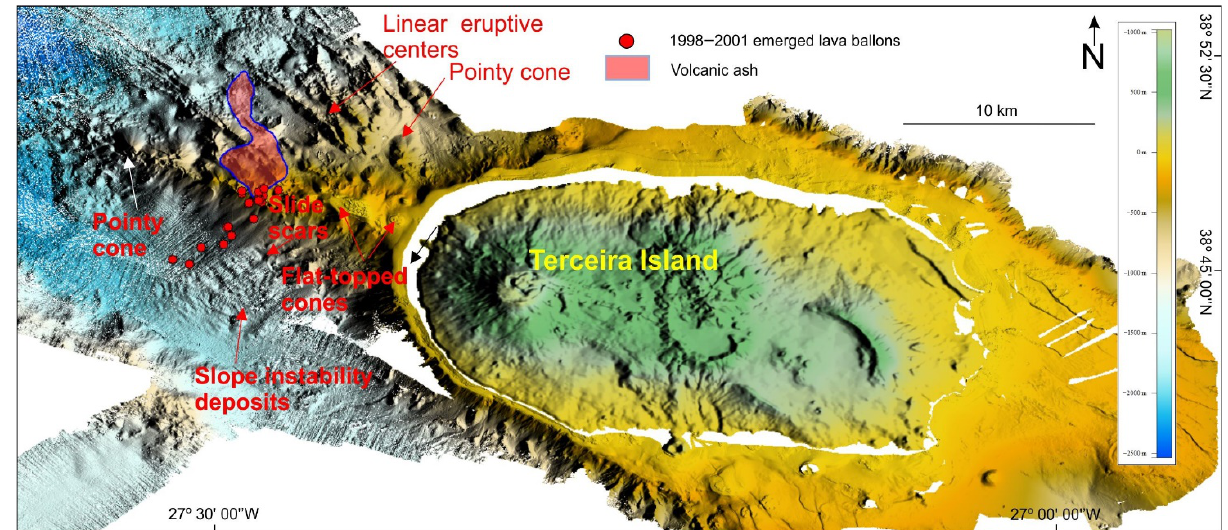
Figure 11. Main characteristics of Terceira Island (Azores; North Atlantic Ocean) and the bathymetry surrounding the island. The map also shows the area where lava balloons clusters and volcanic ash were observed at the sea surface during the 1998–2001 Serreta eruptions; more details on these eruptions can found in [118,229] .